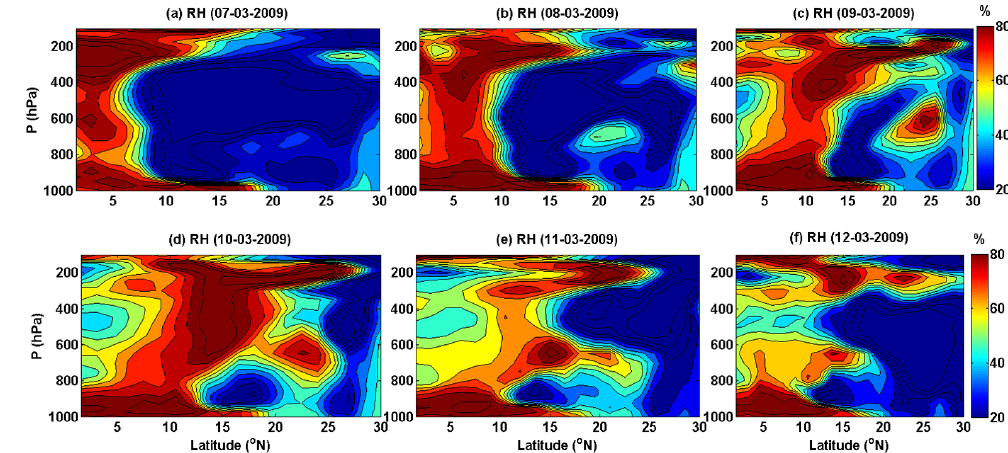
Figure 7. Latitude-height cross section of RH from 7 March to 12 March